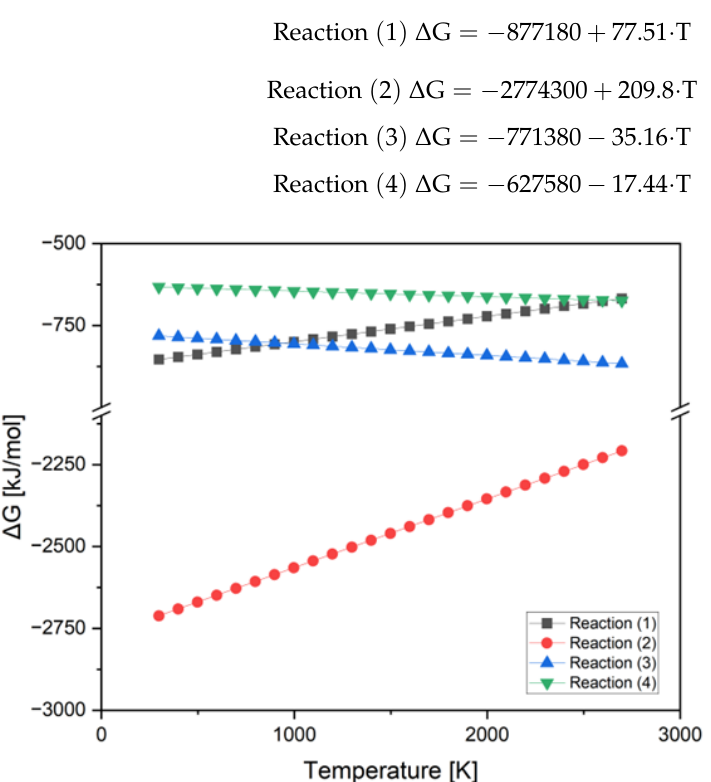
Figure 1. ΔG of reactions 1– 4 as a function of the temperature. Figure 1. ∆ G of reactions 1–4 as a function of the